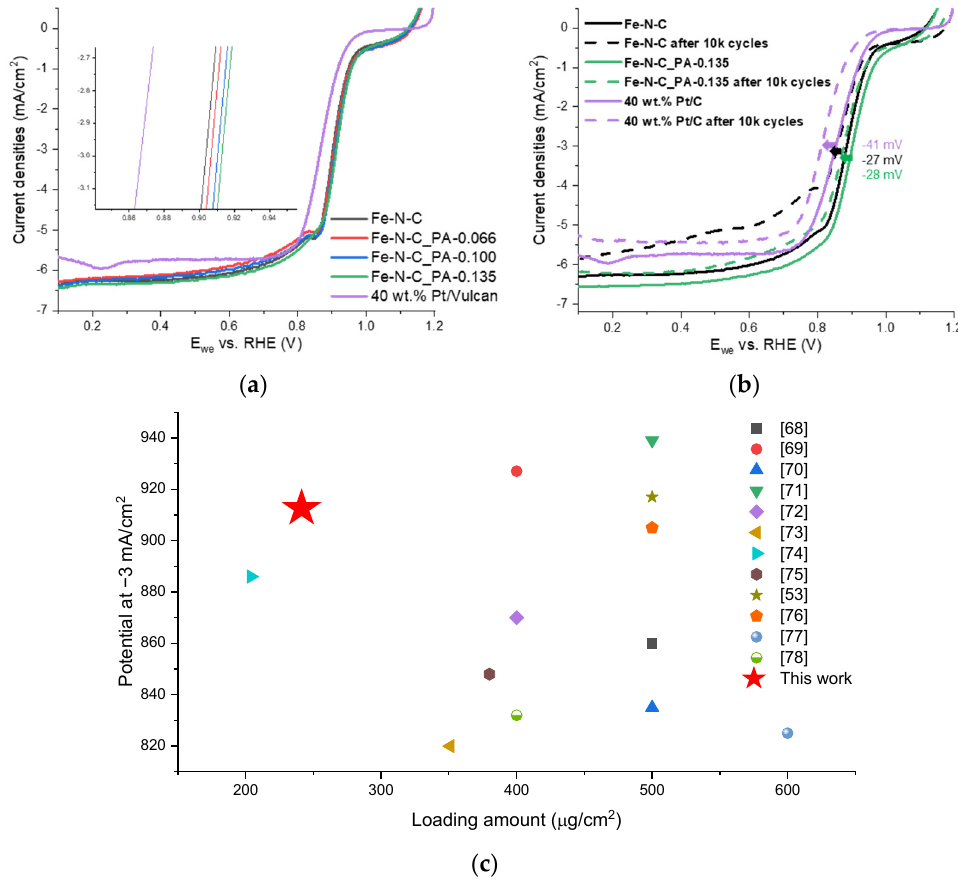
Figure 7. ( a ) Linear sweep voltammograms of Fe-N-C catalysts and Pt/C catalyst; ( b ) durability test result cycling between 0.6 and 1.0 V for 10,000 cycles at a sweep rate of 50 mV/s. The amount of Fe-N-C_PA-0.135 was 480 μg/cm 2 . ( c ) Comparison with reported alkaline ORR Fe-N-C catalysts with potential at −3 mA/cm 2 along the different catalyst loading amount.